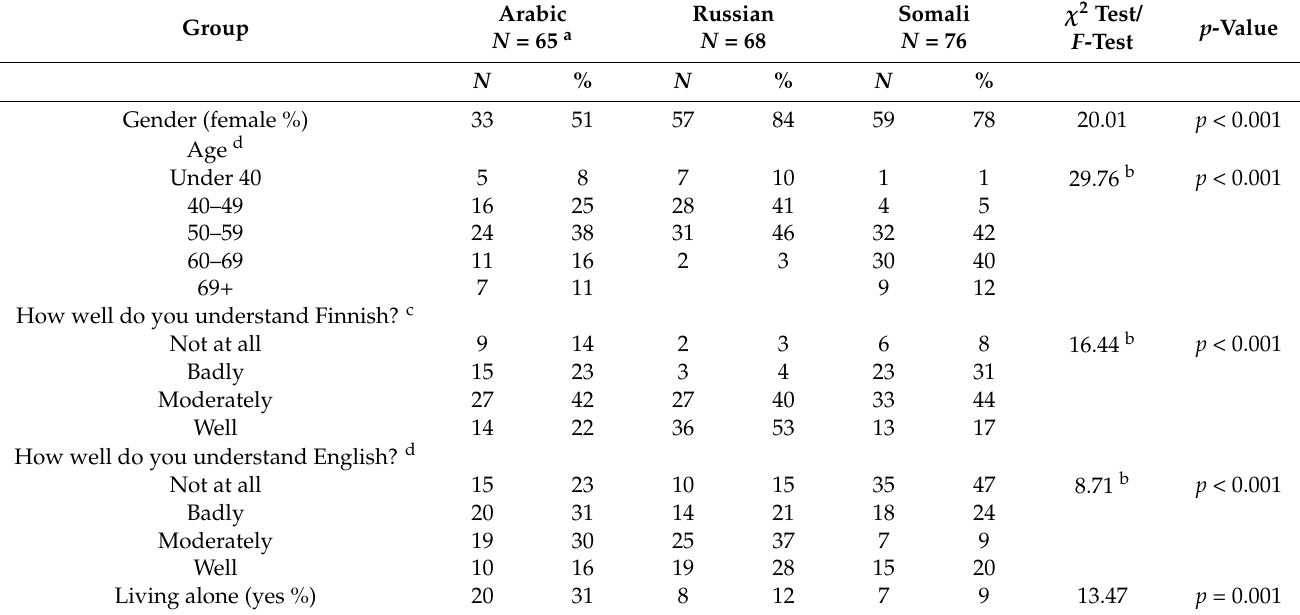
Table 1. Gender, age, Finnish- and English-language skills, and whether respondents lived alone, by migrant group ( N = 209).